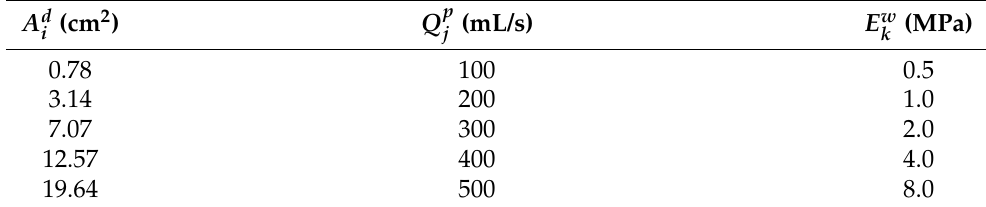
Table 1. List of parameters used for the FSI